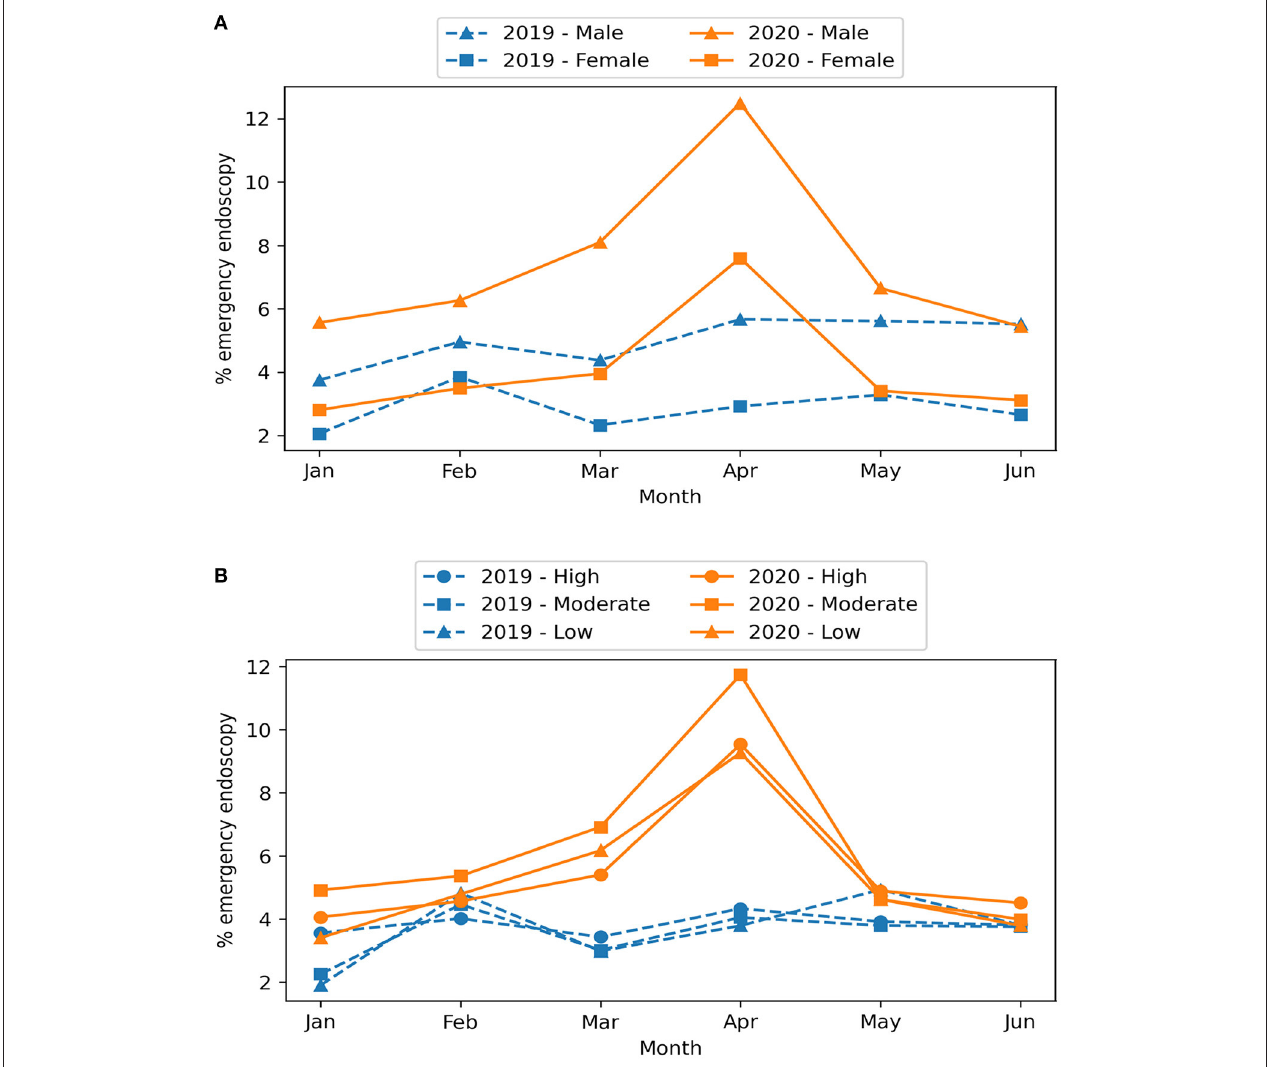
FIGURE 3 | Monthly proportion of GI emergency endoscopy between 2019 and 2020 by sex (A) and COVID-19 risk of the residential area (B) .